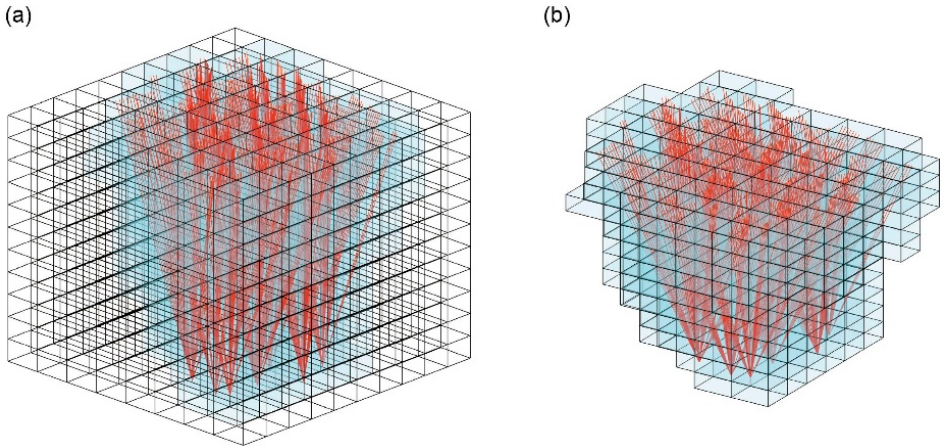
Figure 4. The tomographic region defined by ( a ) the traditional method and ( b ) the 3D traversal algorithm.